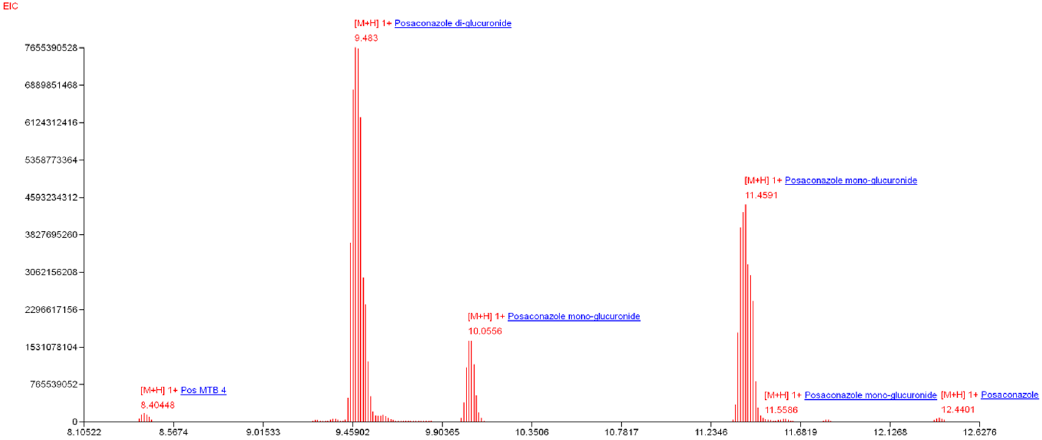
Figure 2. Annotation of posaconazole and its metabolites in the patient’s urine by CycloBranch (15 ppm accuracy, 0.4% minimum relative intensity threshold, 1,000,000 minimum absolute intensity threshold, full pattern with a minimum of three isotope peaks in at least three consecutive scans). The CycloBranch internal mucormycotic database was amended with current antifungals and their metabolites [36].